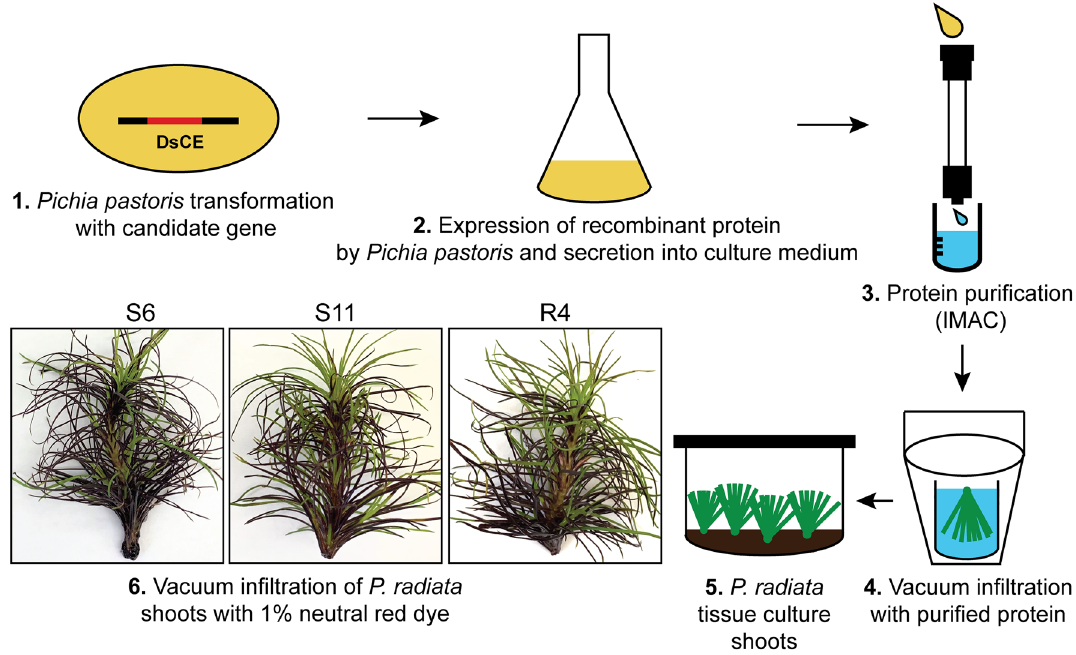
Figure 3. Overview of the pine shoot vacuum infiltration method developed in this study. Dothistroma septosporum candidate effector Ds70057 and positive control Botrytis cinerea effector BcSSP2 proteins were produced through heterologous expression and secretion by Pichia pastoris (1, 2). The proteins were purified by immobilised metal affinity chromatography (IMAC) (3) then vacuum-infiltrated into clonal microshoots of Pinus radiata (4). Infiltrated shoots were returned to LPch media for up to 7 days after infiltration (5). 1% neutral red was infiltrated to assess the efficiency of vacuum infiltration (6) in the different pine genotypes Sus6 (S6), Sus11 (S11) and Res4